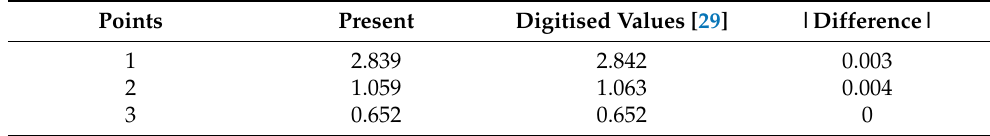
Table 4. The amplitude (mm) of the points represented on Figure 5b. Points Present Digitised Values [29]